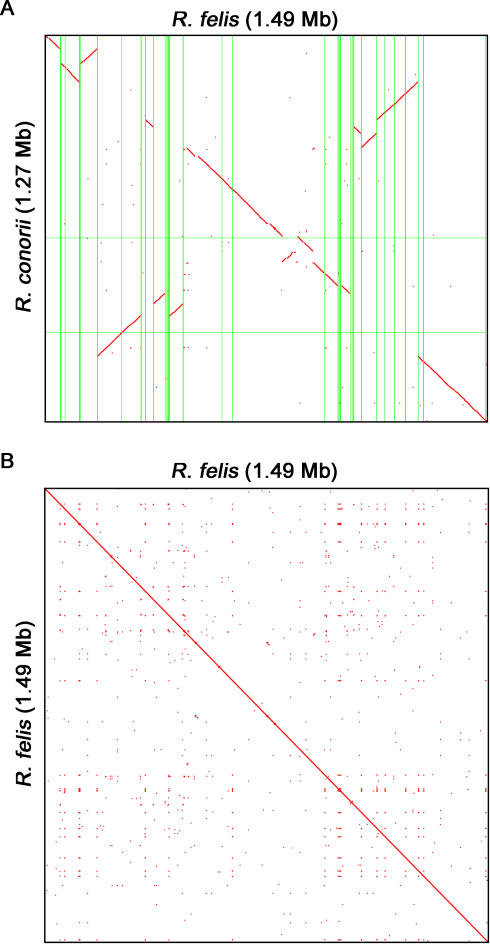
Genome Comparisons of R. felis and R. conorii
Red dots represent homologous genomic segments greater than 150 bp identified by BLASTN (E-value < 10−3).(A) Comparison between R. felis and R. conorii chromosomes. Vertical and horizontal green lines indicate the positions of transposase ORFs in R. felis and in R. conorii, respectively.(B) Self-comparison of R. felis chromosome.